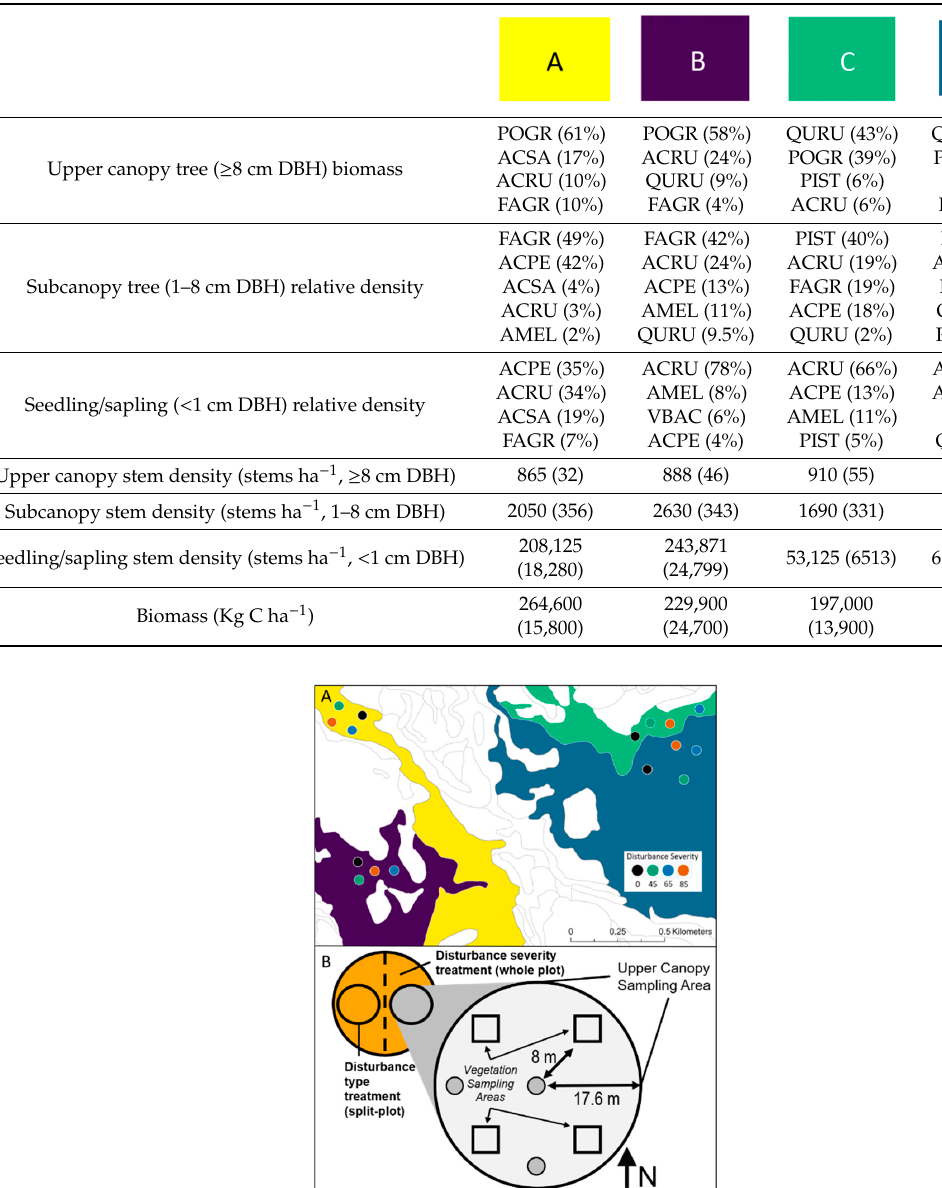
Table 1. Predisturbance tree species composition and stem densities by canopy class, and total aboveground woody biomass for each of four treatment replicates (Figure 1). Canopy classes are defined by diameter at breast height (DBH). The four most abundant canopy and seedling / sapling species, and the five most abundant subcanopy species, are provided. Species abbreviations are: Populus grandidentata (POGR), Quercus rubra (QURU), Acer rubrum (ACRU), Acer saccharum (ACSA), Fagus grandifolia (FAGR), Pinus strobus (PIST), Pinus resinosa (PIRE), Acer pensylvanicum (ACPE), Amelanchier (AMEL), and Viburnum acerifolium (VBAC). Standard errors for stem densities and biomass Forests 2020 , 11 , x FOR PEER REVIEW are presented parenthetically.